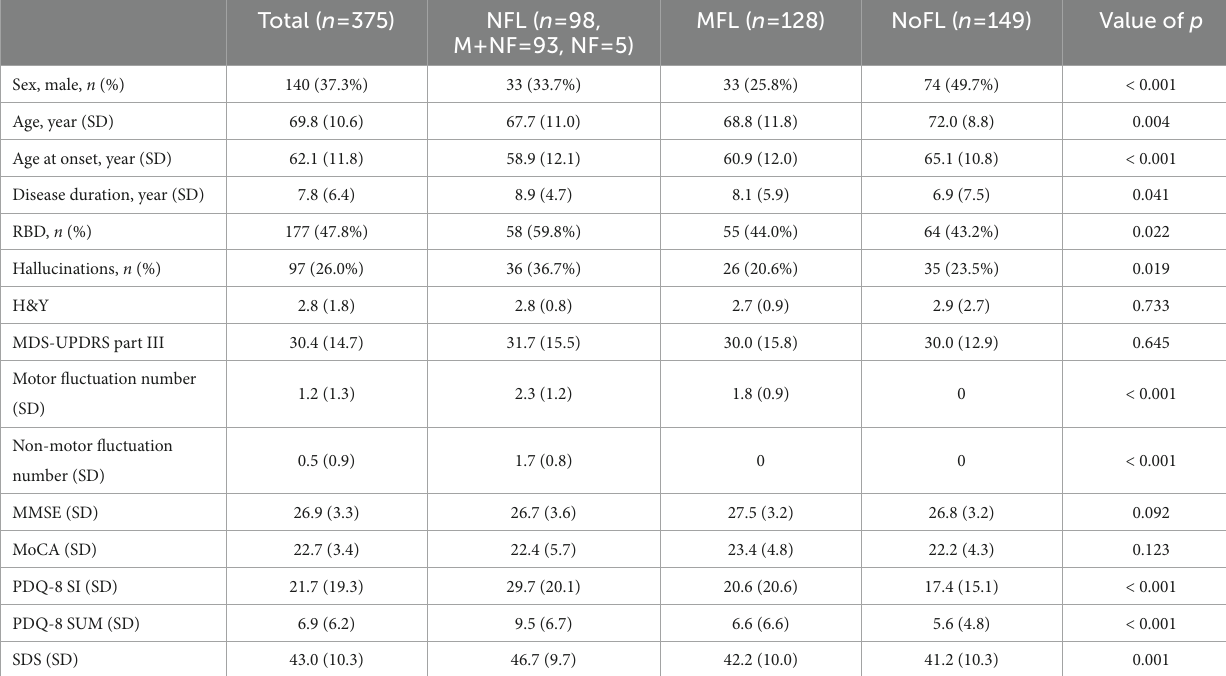
TABLE 1 Demographics and clinical characteristics.